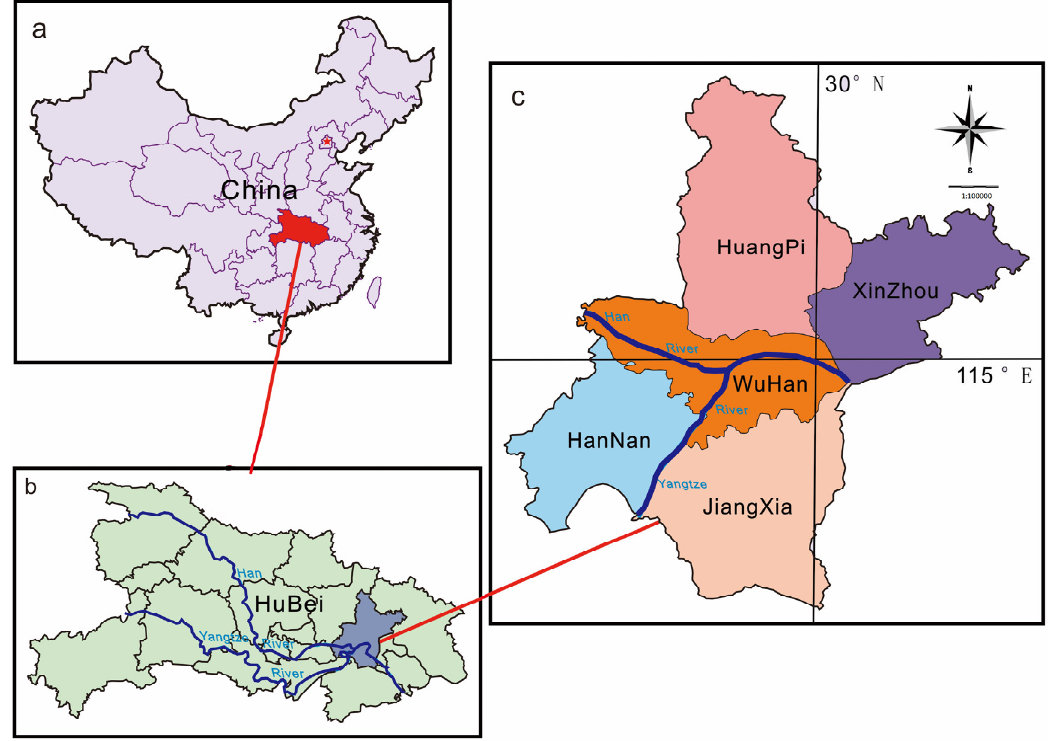
Figure 1. Location of Wuhan, China: ( a ) location of Hubei Province in China; ( b ) location of Wuhan in Hubei Province; and ( c ) geographical distribution in